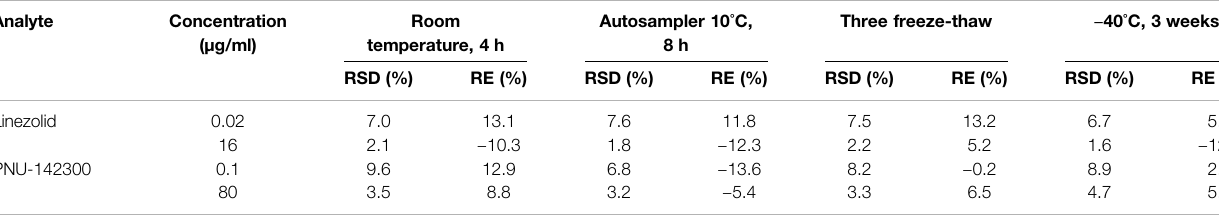
TABLE 4 | Patient characteristics and the concentrations of linezolid and PNU-142300 strati fi ed by renal function. Parameters